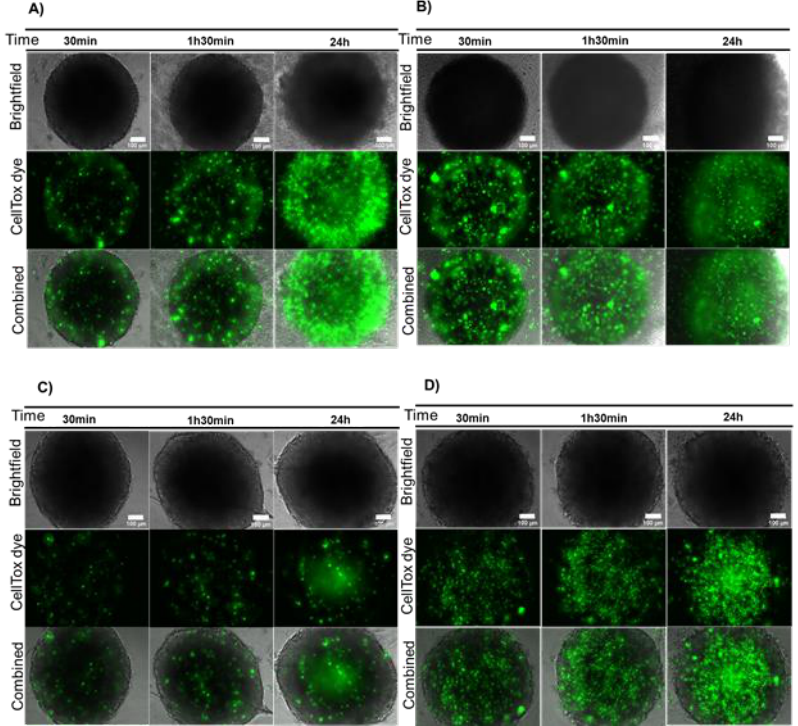
Figure 1 . AuNP@PEG effect on cell viability measured by CellTox green dye. ( A ) HCT116 spheroids incubated for 24 h with 8 nM AuNP@PEG; ( B ) HCT116-DoxR spheroids incubated for 24 h with 8 nM AuNP@PEG; ( C ) HCT116 spheroids alone; ( D ) HCT116-DoxR spheroids alone. Microscopy images were acquired in Brightfield or with a green fluorescence filter to evaluate CellTox green dye fluorescence, after 30 min, 1 h 30 min or 24 h incubation. The combined images result from the overlap between Brightfield and green filter images. Scale bar corresponds to 100 μm.